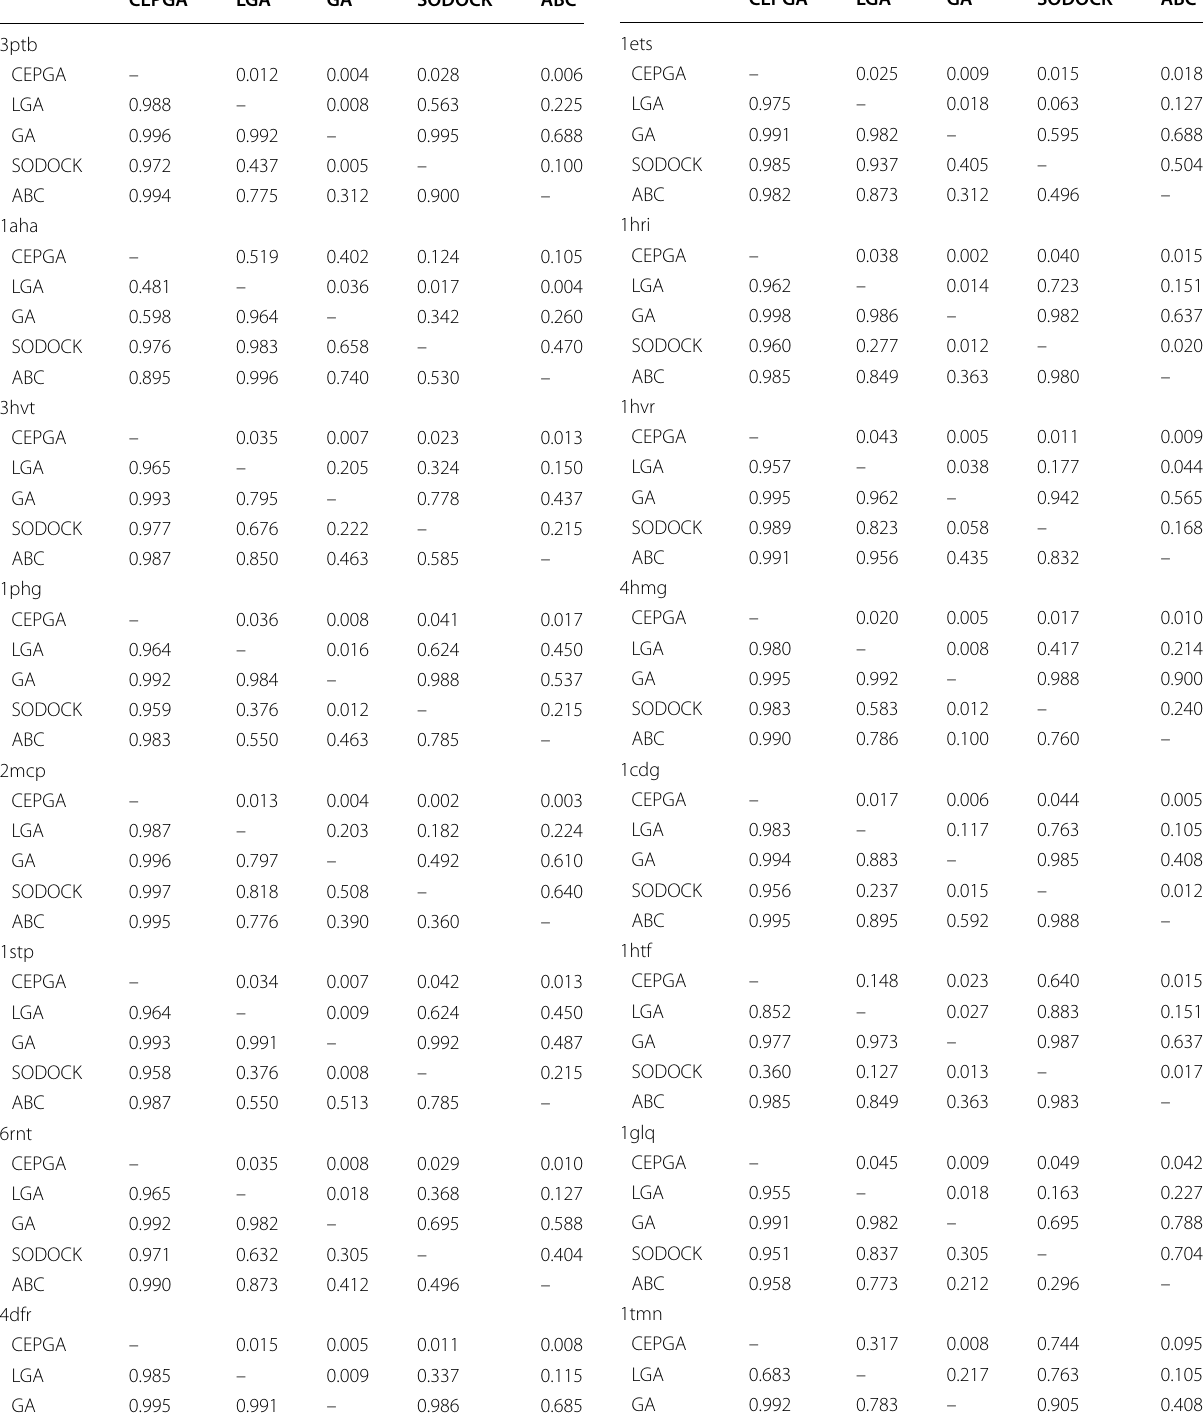
Table 3 Hypothesis test